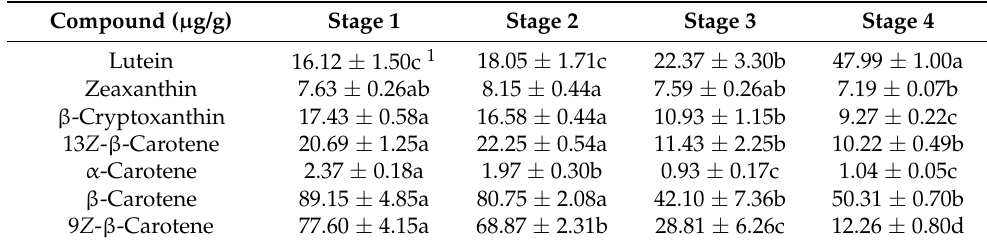
Table 1. HPLC analysis of carotenoids in the different flowering stages of L . radiata .